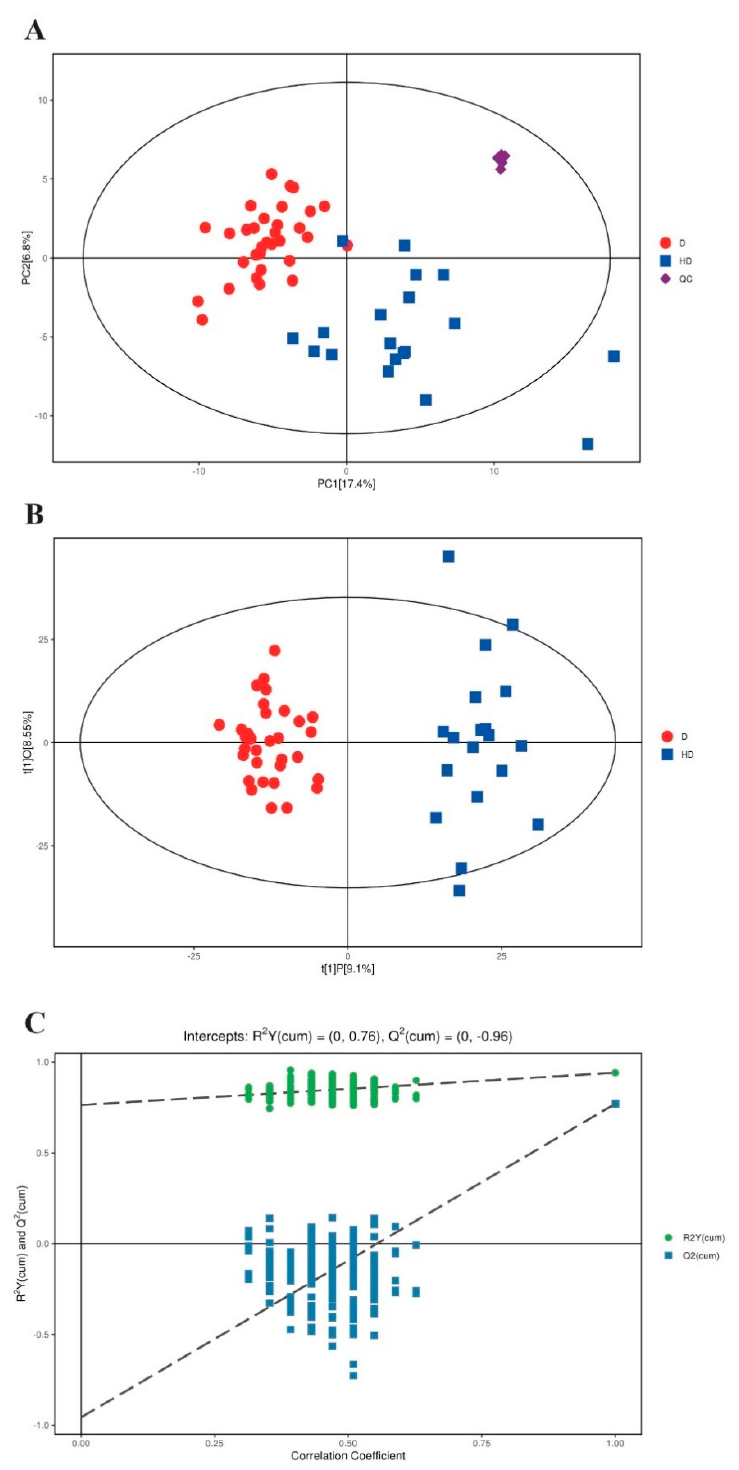
Figure 2. Metabolic profiling of serum samples from patients with T2DM and T2DM(+) HCC in the discovery cohort. ( A ) The PCA score plot based on the combinational data of ESI+ and ESI − modes. ( B ) The OPLS–DA score plot based on the combinational data of ESI+ and ESI − modes. ( C ) Validation of the OPLS–DA model by the permutation test. Colors and shapes display the subjects from different groups. D refers to T2DM patients, and HD refers to T2DM(+) HCC patients. T2DM, type 2 diabetes mellitus; HCC, hepatocellular cancer; PCA, principal component analysis; OPLS–DA, orthogonal projections to latent structures–discriminate analysis; QC, quality control.